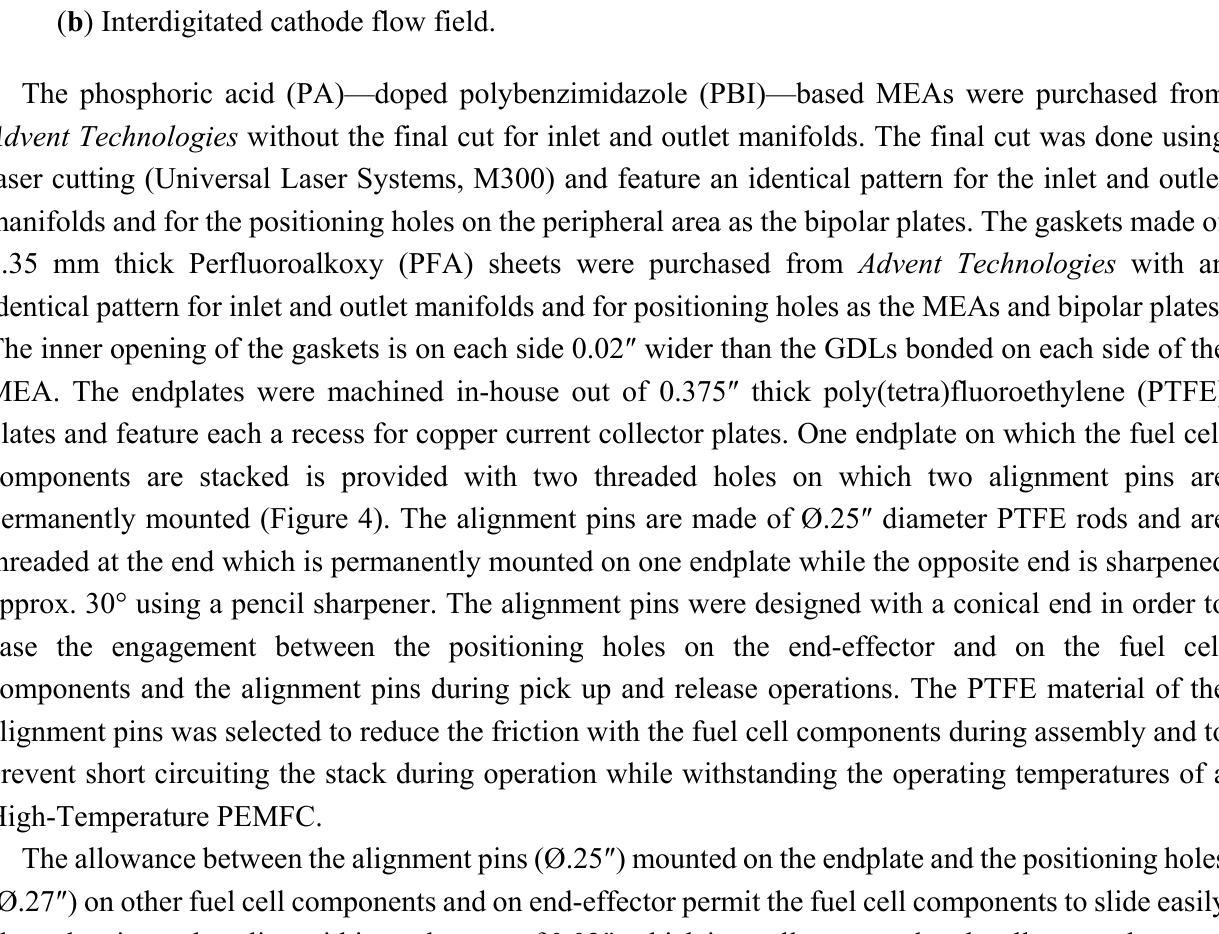
Figure 3. Bipolar plates used for robotic assembly of the fuel cell stack. The figure shows two positioning holes for centering pins. ( a ) 5-channel serpentine anode flow field; ( b ) Interdigitated cathode flow